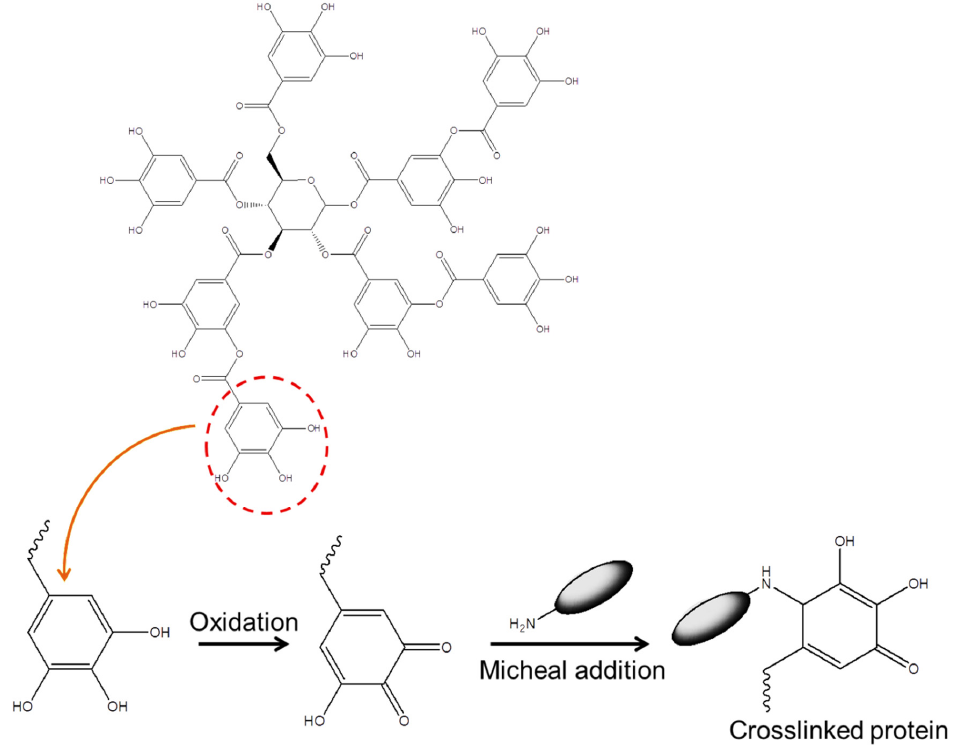
Figure 5. Mechanism of crosslinking of proteins/peptides by tannic acid.